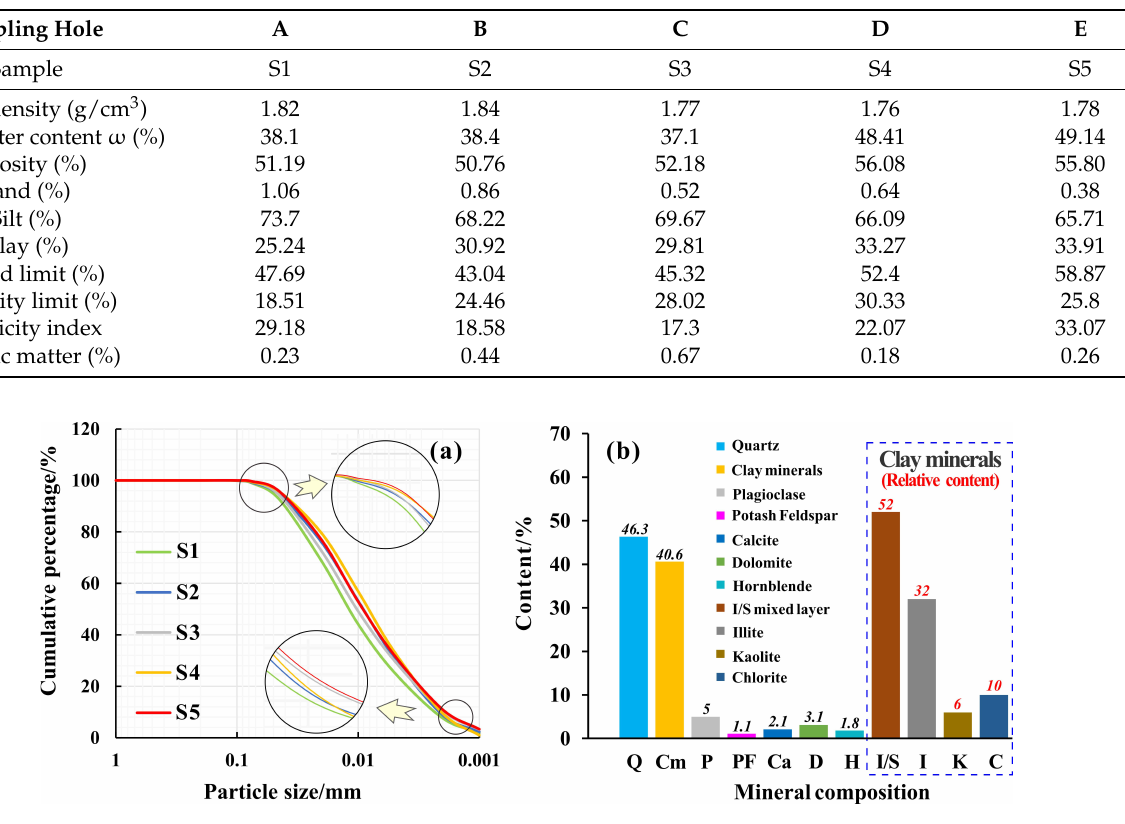
Figure 3. Material composition of natural soil: ( a ) grain size distribution (S1–S5); ( b ) mineral